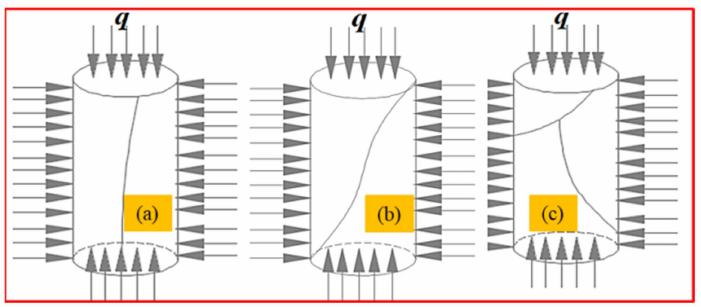
Figure 2. Different failure modes.